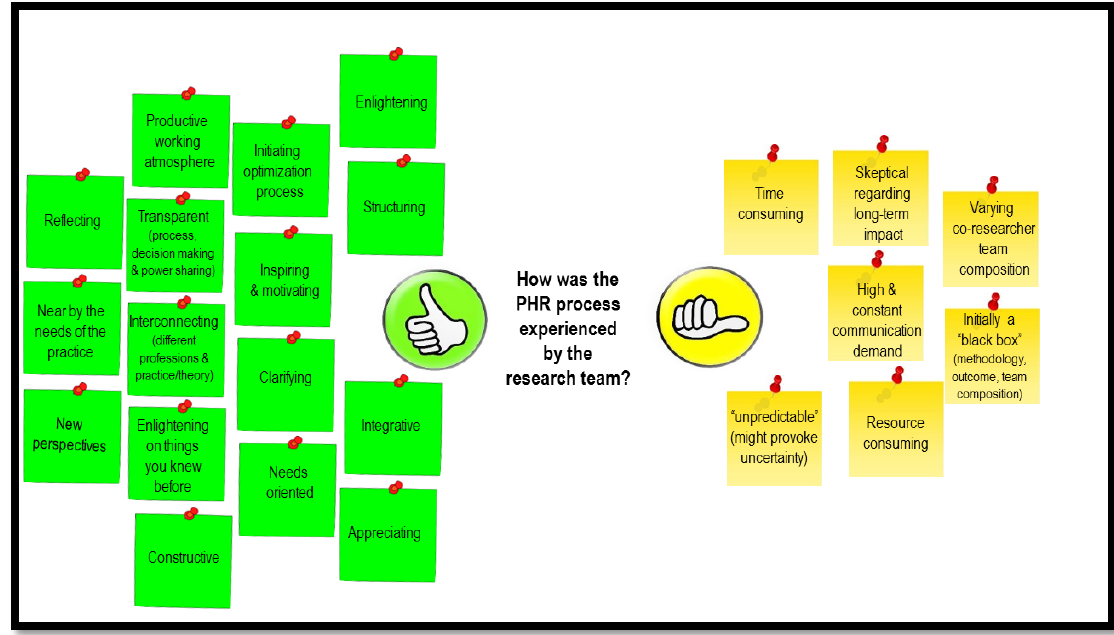
Figure 2. Perceived benefits and limitations of the PHR approach within the geriatric hospital setting: outcomes of the brainstorm session in the final meeting.